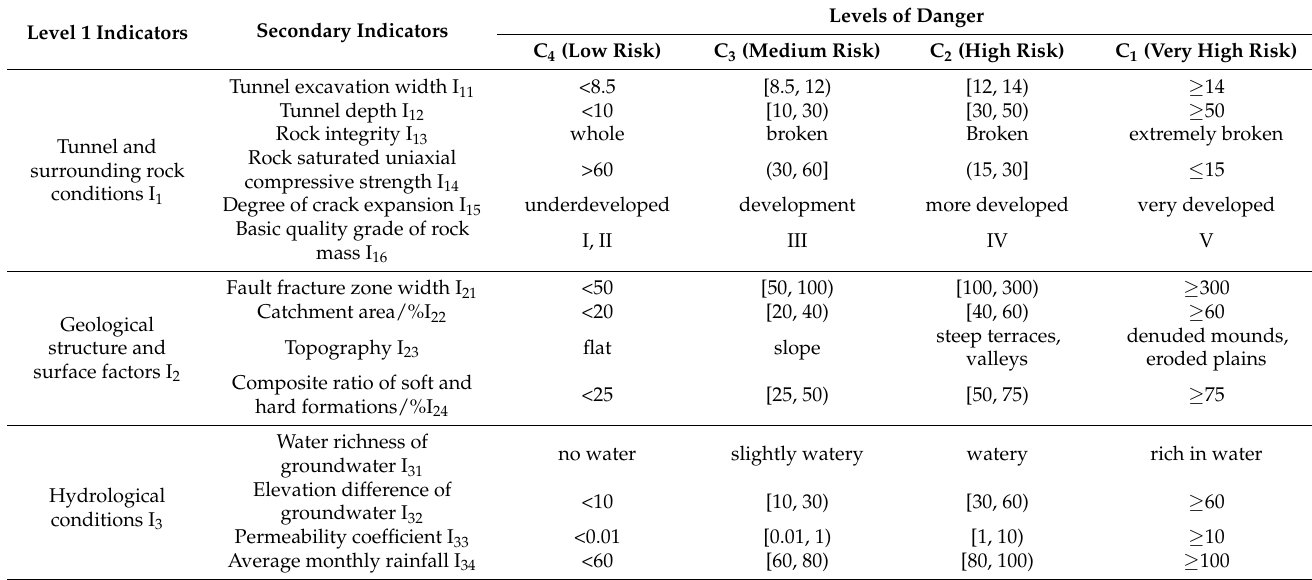
Table 4. Risk assessment index system for tunnel water inrush in the Qingdao area.